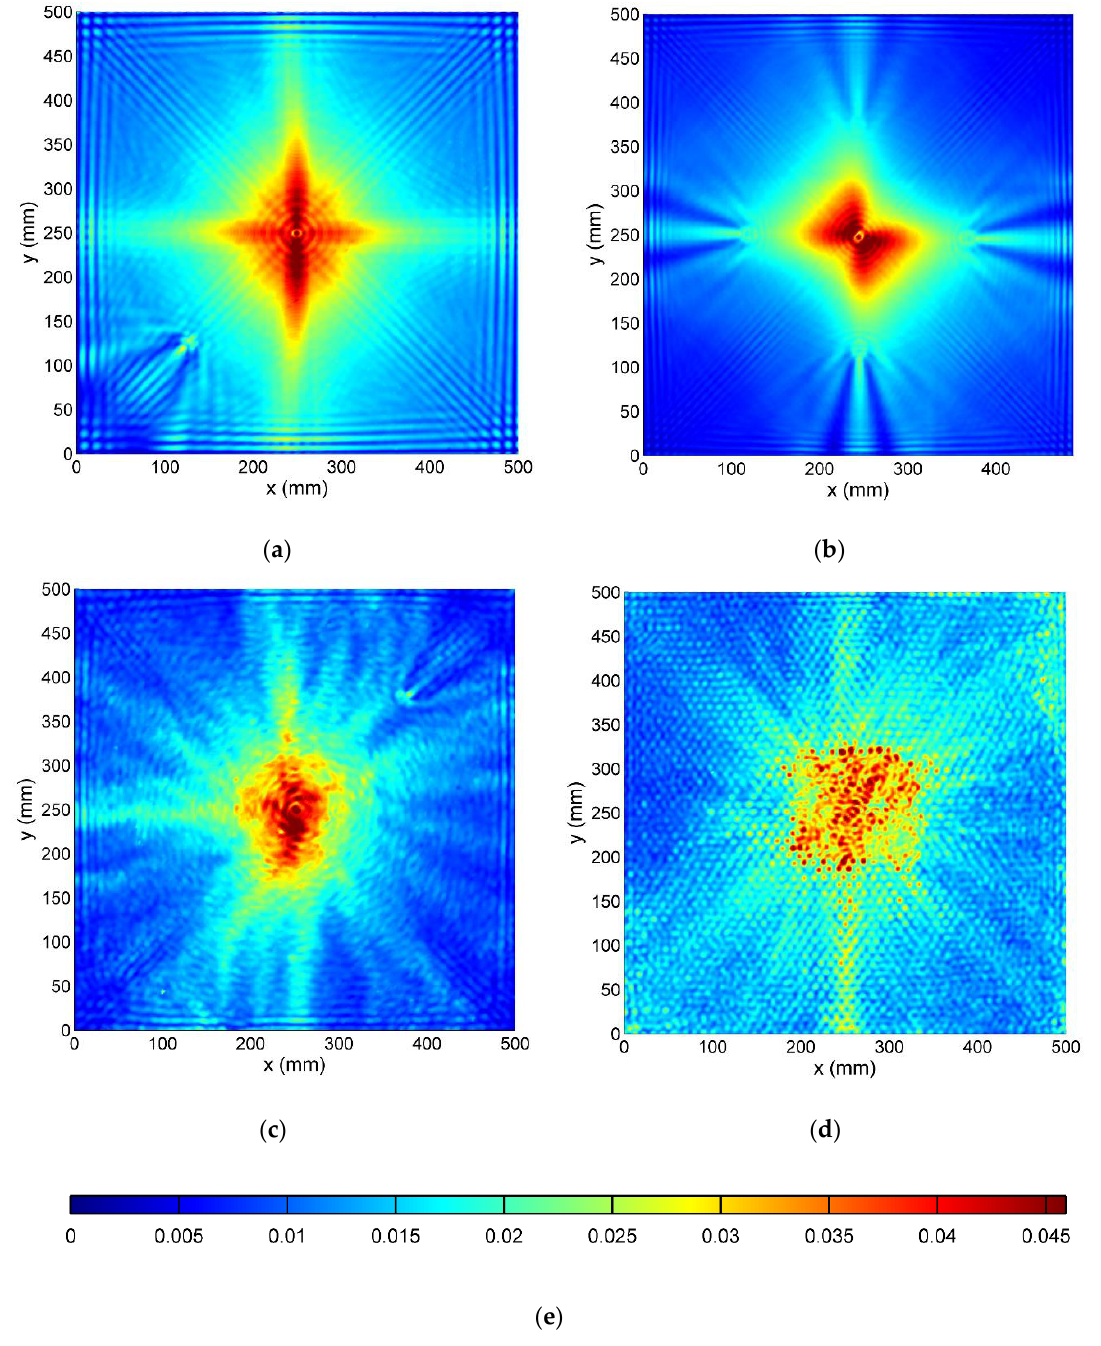
Figure 7. RMS maps for: ( a ) CFRP; ( b ) GFRP; ( c ); SFRP ( d ); HCSP specimen; ( e ) Color scale.